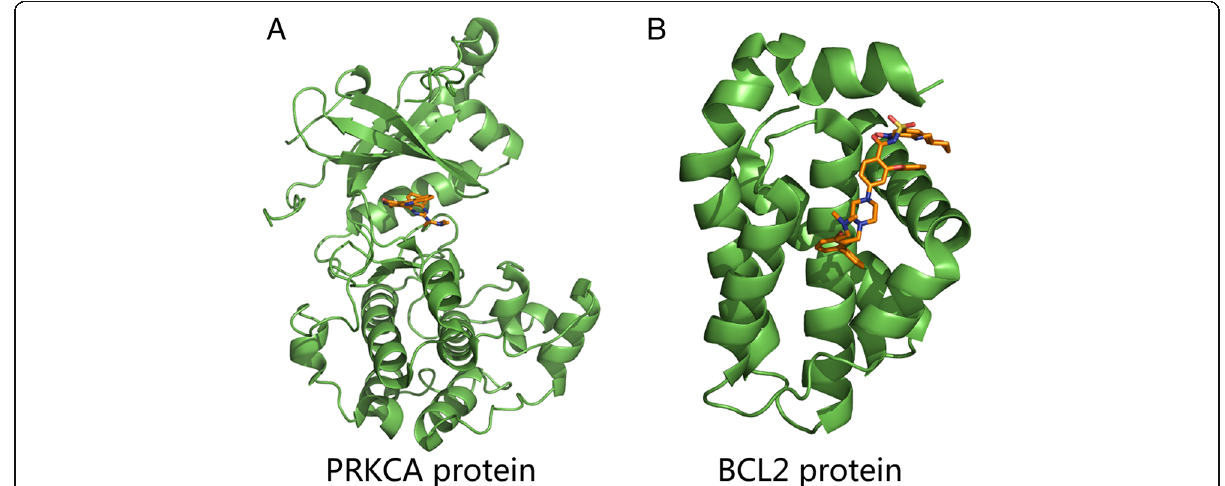
Fig. 7 The binding sites of PRKCA and BCL2. a Three-dimension structure of PRKCA. b Three-dimension structures of BCL2. The proteins are shown in green cartoon and the co-crystalized inhibitors are shown in orange